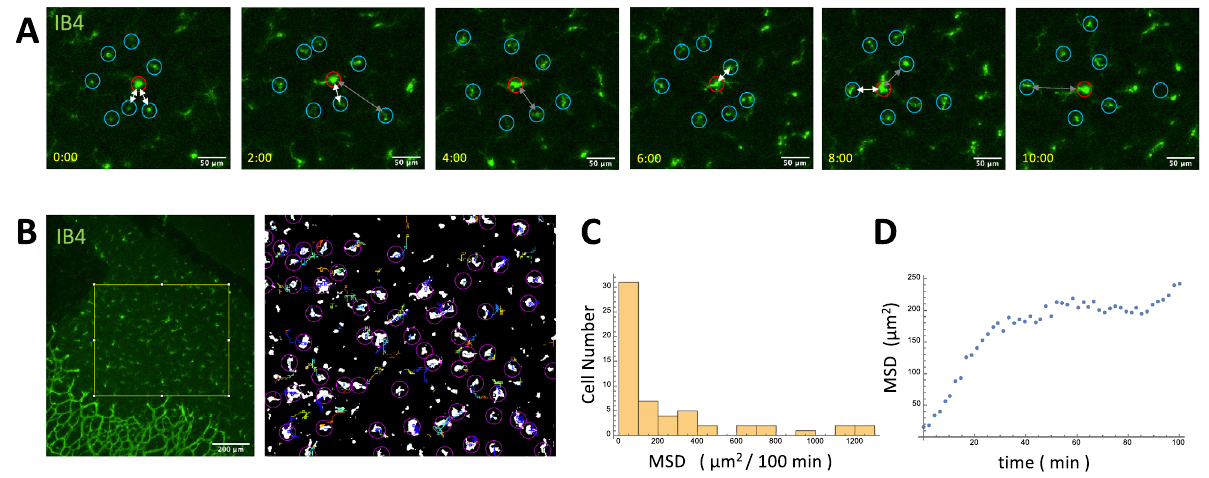
Figure 4. Dynamics of microglial soma in organ culture. ( A ) Microglia (red circle) moving randomly and repelling surrounding other microglia (blue circles) tracked for 10 h. White arrows represent the pairs of microglia close to each other, and gray arrows represent the pairs of microglia that move away after approaching. ( B ) We tracked the microglia migration inside the yellow square in the left panel for 12 h. The right panel shows that white regions representing each cell’s first position and color lines representing each cell’s 12-h trajectory. ( C ) The Histogram of MSD. We chose trajectories we could track for 50 frames (100 min, n = 58). ( D ) The mean MSD reached a plateau after 40